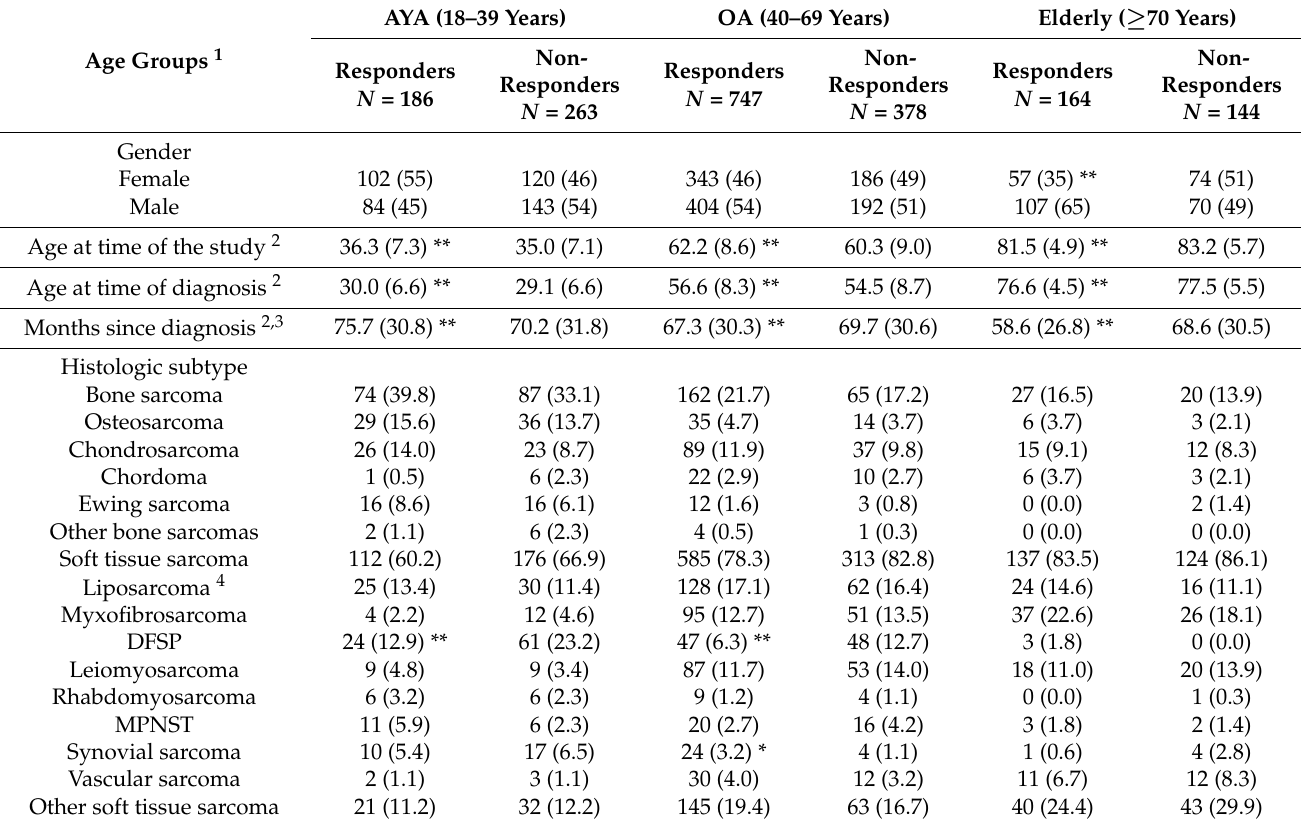
Table 1. Responders compared to non-responders according to age